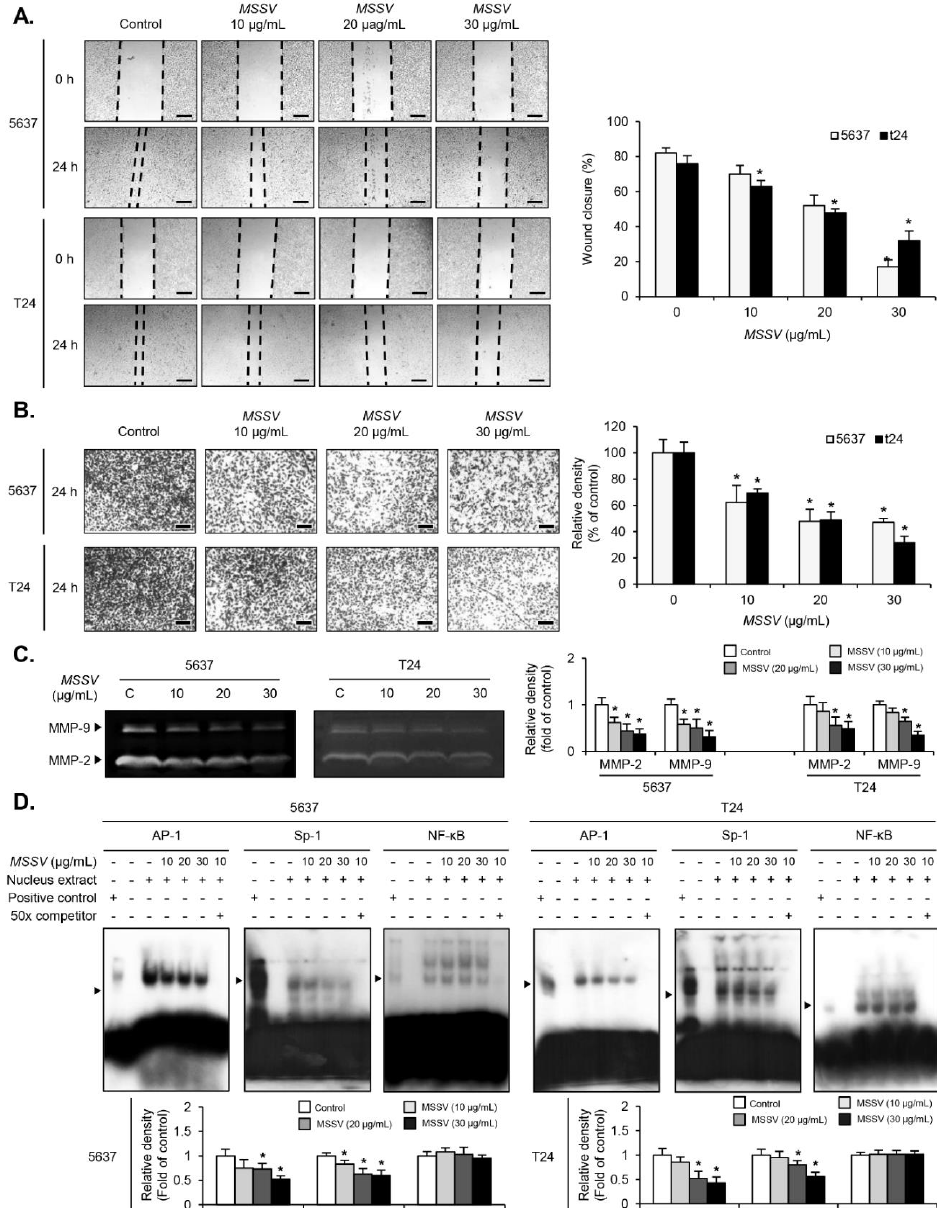
Figure 4. MSSV represses the migration and invasion of bladder cancer cells by suppressing transcription factor-mediated MMP-9 activity. Both 5637 and T24 cells were pretreated with mitomycin C, followed by incubation with MSSV for 24 h. ( A ) Cellular images of migratory recovery rate of 5637 and T24 cells photographed under an inverted microscope (scale bars = 200 µ m). Bar graphs represent the relative fold changes in migration distances as compared with the control. ( B ) Treatment with MSSV inhibited the invasion ability of both bladder cancer cells (scale bars = 200 µ m). Both cells were added onto the upper chamber and incubated with the indicated concentrations of MSSV for 24 h. Cells invading the lower surface of the membrane were detected by crystal violet staining. In the bar graphs, the amount of invading cells was assessed as the fold change compared with the control. ( C ) Zymographic assay was performed to determine MMP-9 expression in cells isolated from the cultured medium. Proteolytic activity of each MMP-9 was detected as a fold change compared with the control. ( D ) Nuclear extracts were subjected to EMSA assay to test the binding activities of activator protein 1 (AP-1), specificity protein 1 (Sp-1), and nuclear factor kappa-light-chain-enhancer of activated B cells (NF- κ B) using radiolabeled oligonucleotide probes. Unlabeled AP-1, Sp-1, and NF- κ B oligonucleotides were used as competitors. For the bar graphs, values are expressed as the mean ± SD of three independent experiments; * p < 0.05, compared with the control